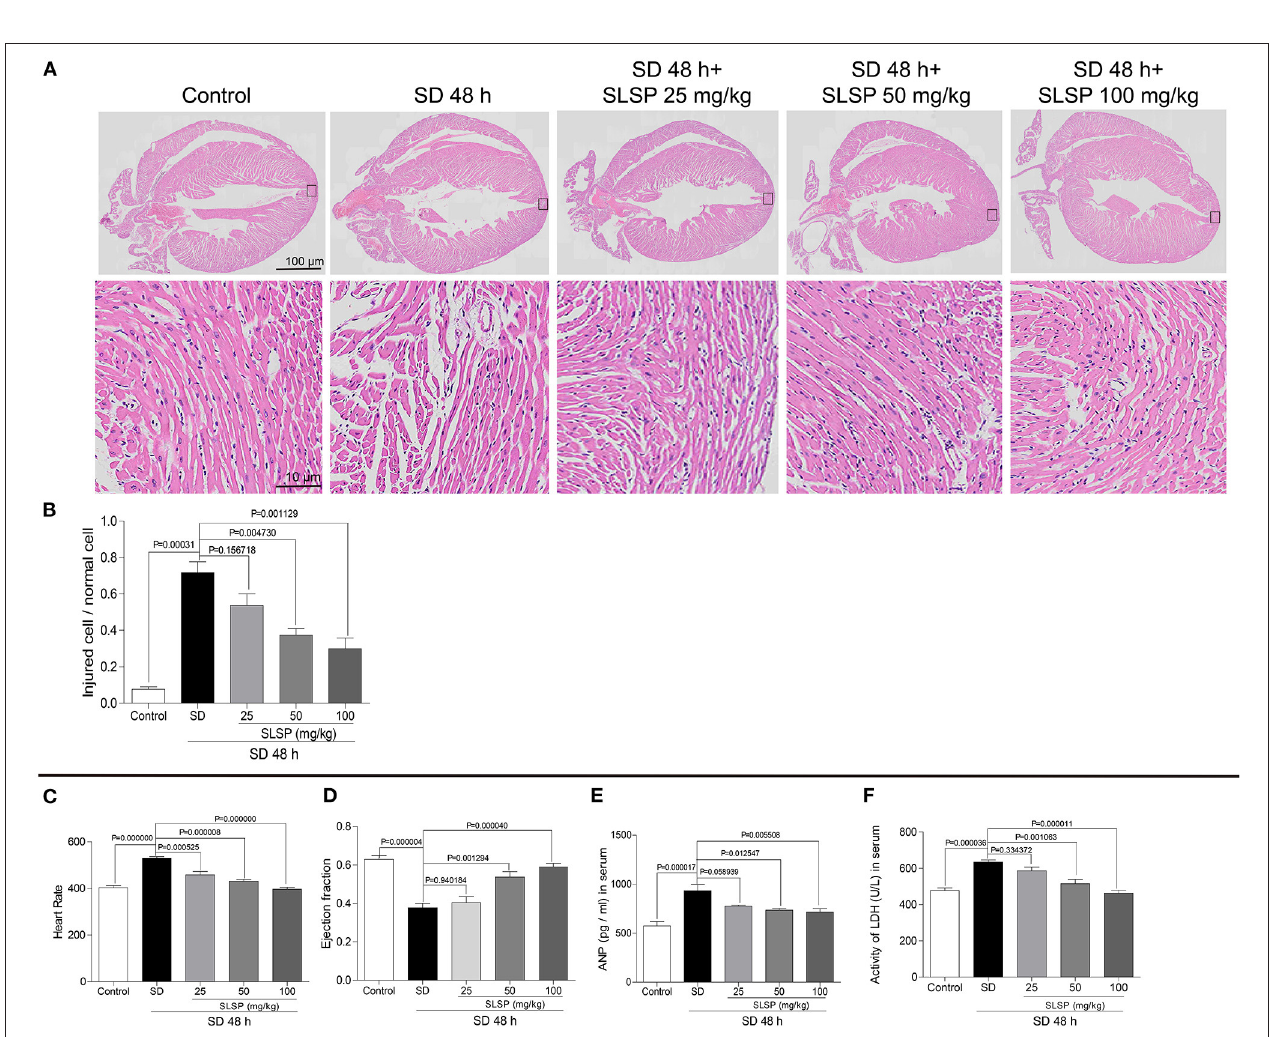
FIGURE 2 | SLSP inhibited abnormal changes in cardiac tissue morphology (A,B) , heart rate (C) , ejection fraction (D) , serum ANP (E) , and serum LDH (F) in SD mice. N = 3/group.